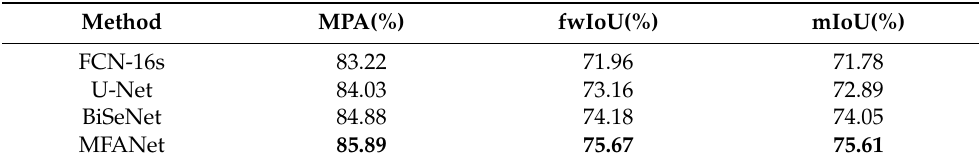
Table 8. Results on aerial image segmentation dataset (AISD) testing set (bold represents the best result).